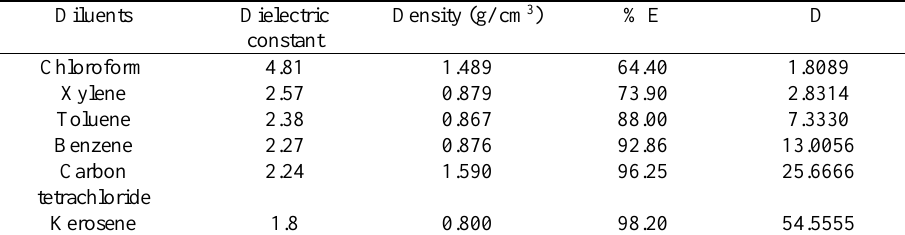
Table 2. Effect of diluents on the extraction of copper